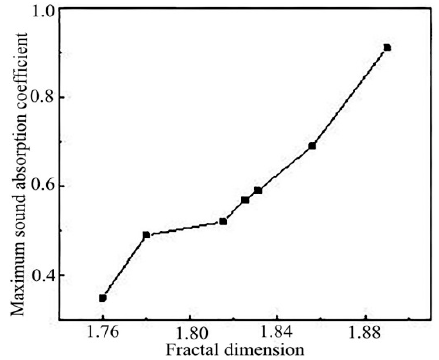
Figure 14. Relationship between fractal dimension and maximum sound absorption coefficient.